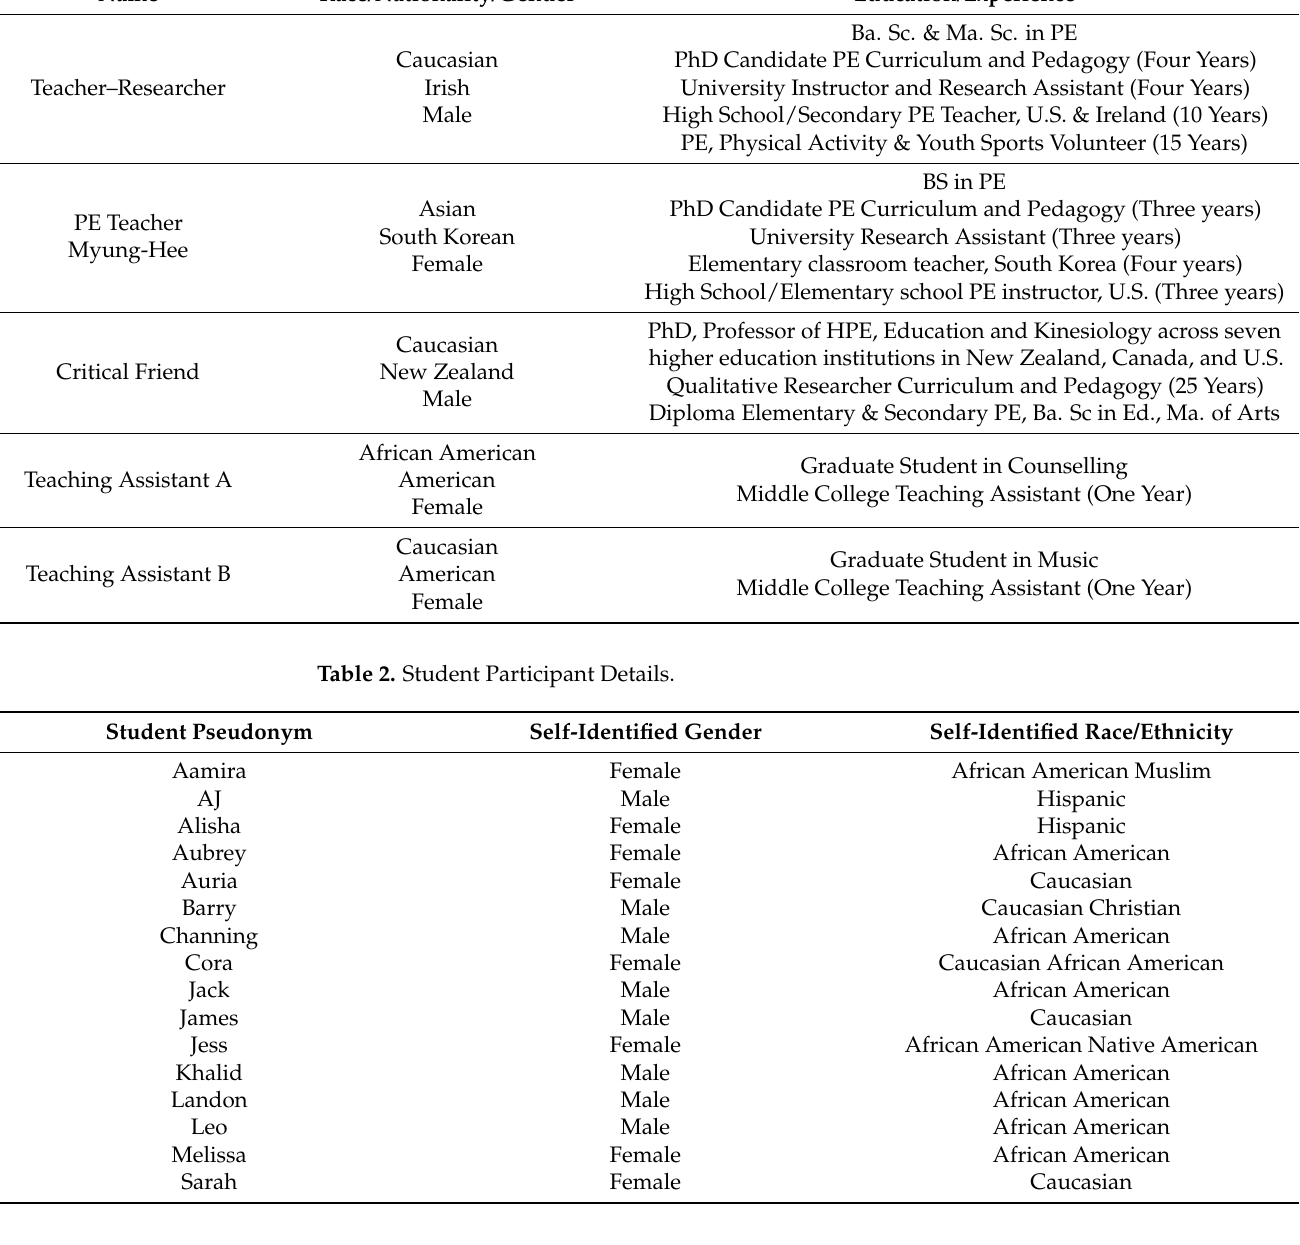
Table 3. Enacted Pedagogies Drawn from